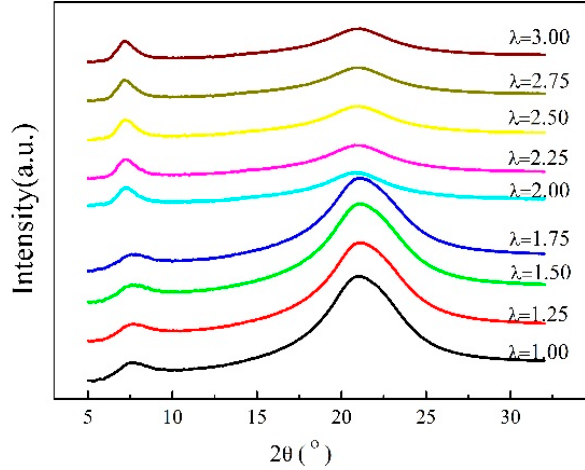
Figure 2. XRD patterns of γ -PA1010 stretched at RT.